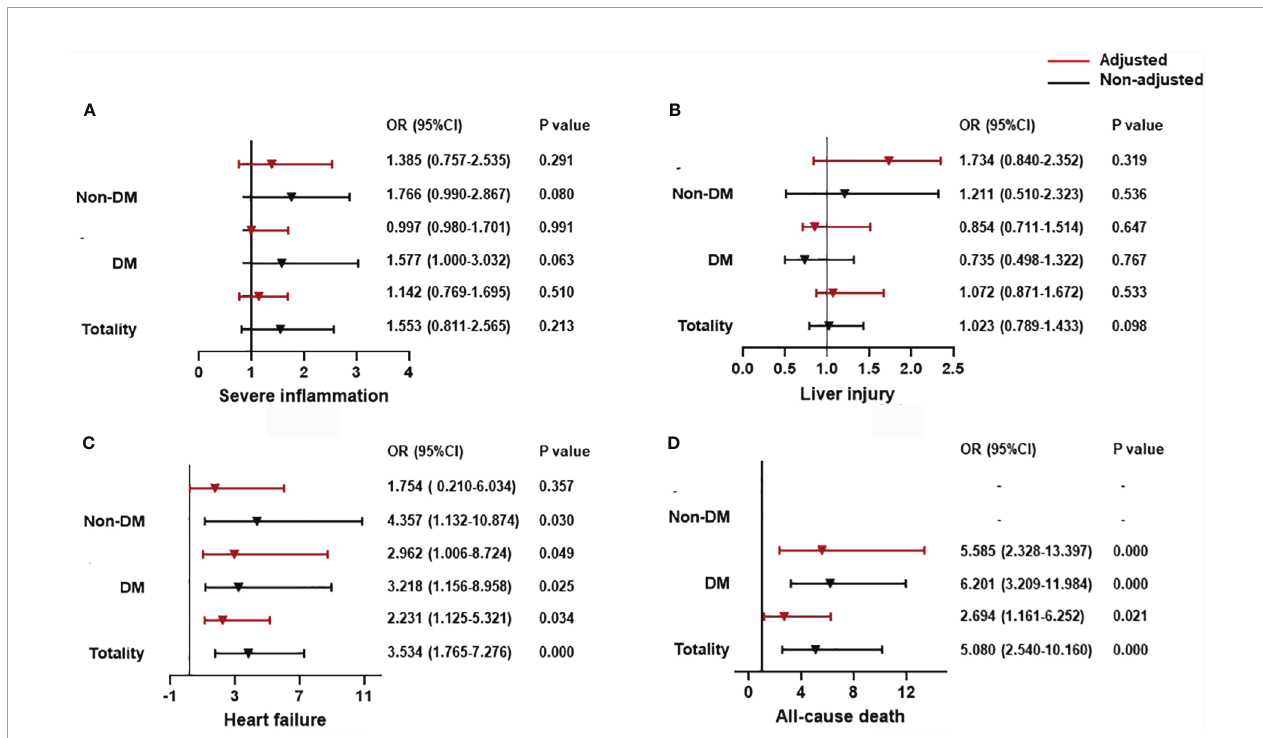
FIGURE 1 | The association between CysC and organ dysfunction and all-cause death classi fi ed by T2DM. (A) The association between CysC and severe in fl ammation classi fi ed by T2DM. (B) The association between CysC and liver injury classi fi ed by T2DM. (C) The association between CysC and heart failure classi fi ed by T2DM. (D) The association between CysC and all-cause death classi fi ed by T2DM. Severe in fl ammation was de fi ned as the highest NLR >6.11 during hospitalization; liver injury was de fi ned as a level of ALT >40 U/L at any time during hospitalization; and heart failure was de fi ned as the highest level of NT-proBNP>300 pg/mL during hospitalization. Adjusted by age, severe pneumonia, serum albumin, blood glucose, log NT-proBNP baseline. T2DM, type 2 diabetes mellitus; CysC, cystatin C; NLR, neutrophil-to-lymphocyte ratio; ALT, alanine aminotransferase; NT-proBNP: N terminal pro B type natriuretic